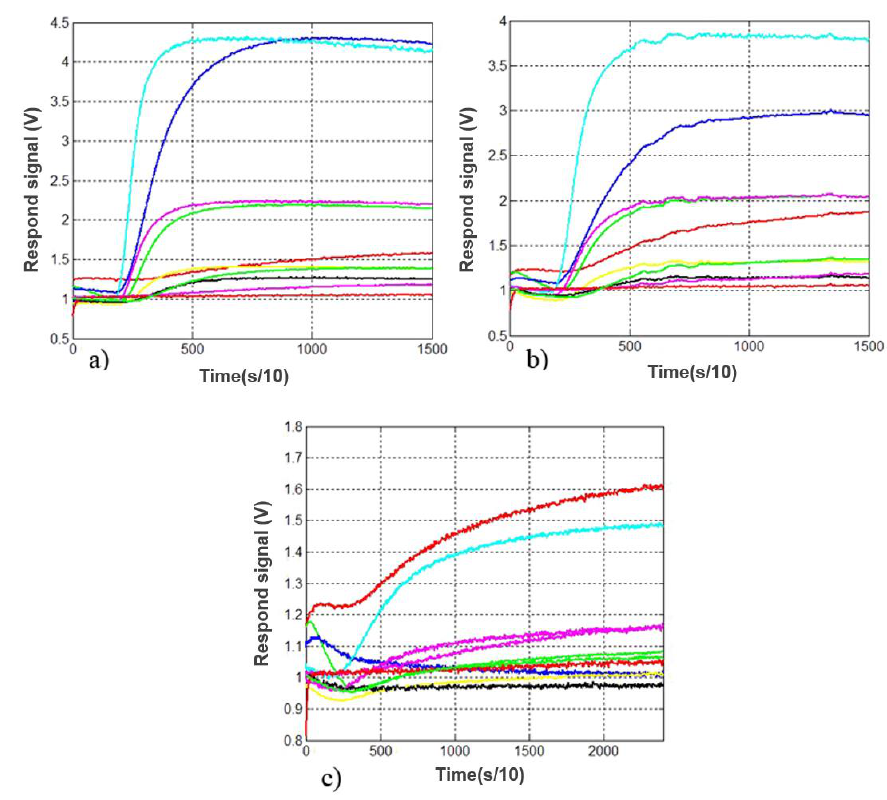
Figure 3. The typical original electronic nose response signals of ( a ) pork; ( b ) beef and ( c ) mutton.